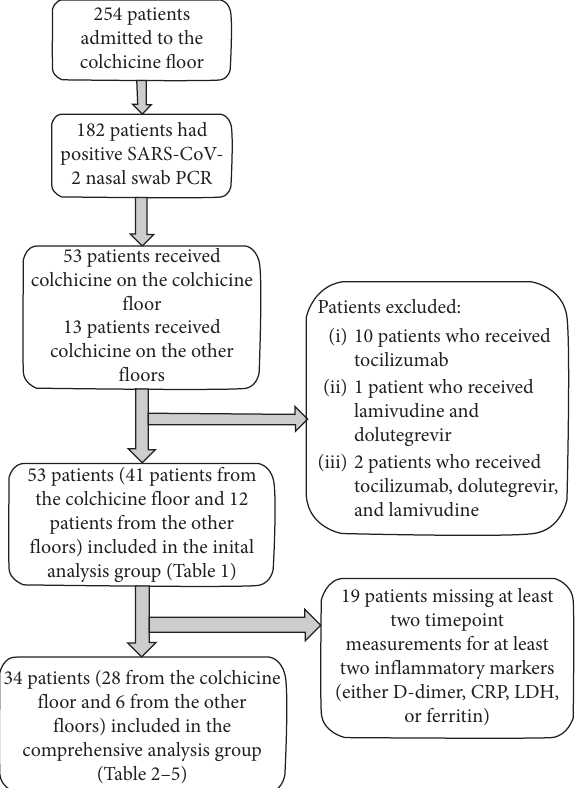
Figure 1: A flow diagram of the selection process for the patients in the colchicine